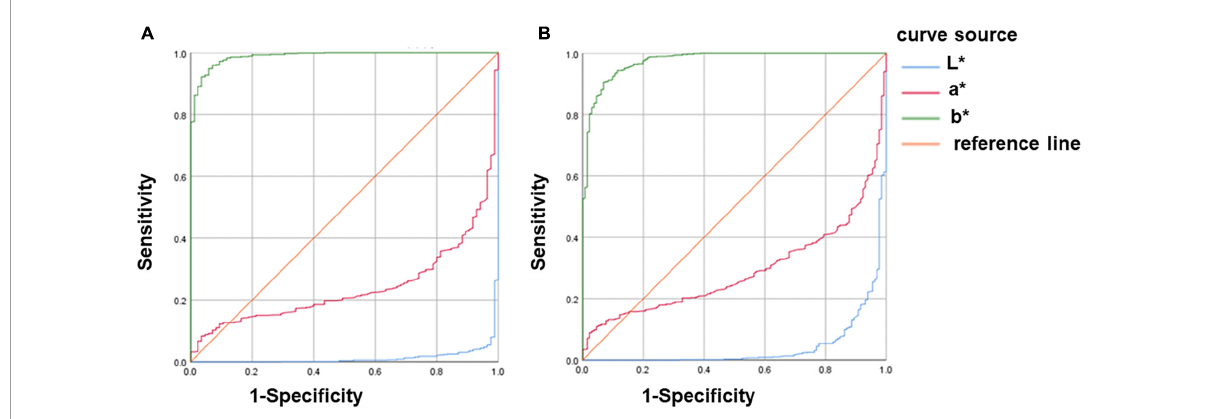
FIGURE5 ROC curve analysis of urine colour L*a*b* for assessing hyperhydration. (A) Hyperhydration was defined as Usg ≤ 1.010. (B) Hyperhydration was defined as Uosm ≤ 500mmol/kg; Uosm, urine osmolality; and Usg, urine specific gravity.